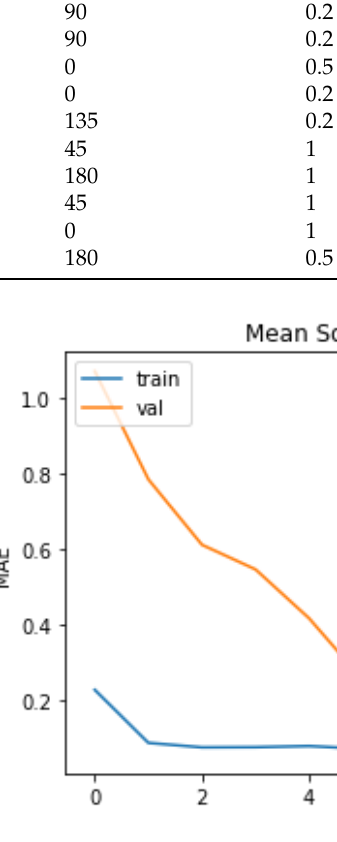
Figure 3. The training and validation MSE loss for each epoch of the NN with one-hot encod- ing